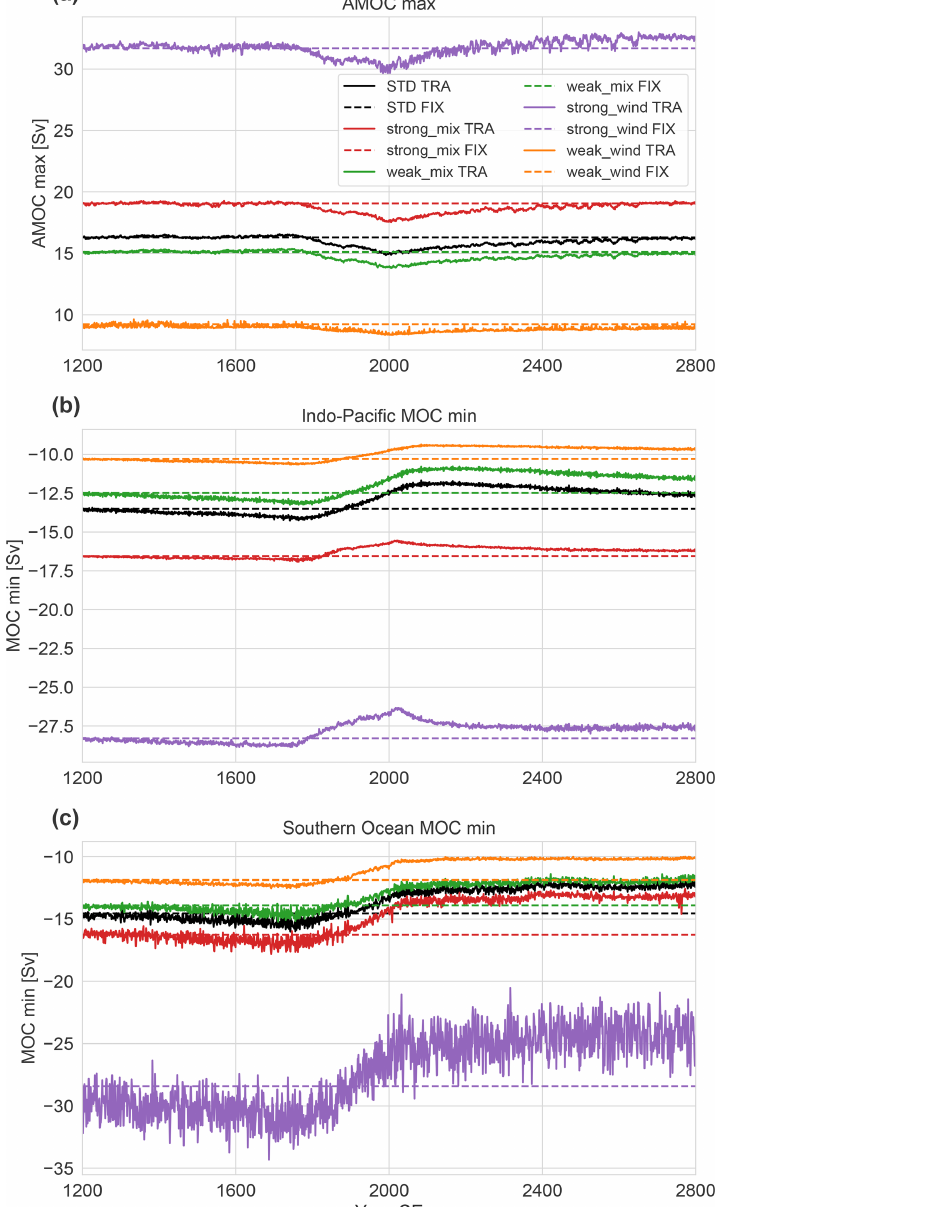
Figure A4. For simulations with varying parameters: (a) Atlantic Meridional Overturning Circulation (AMOC) maximum, (b) minimum of the MOC in the combined Pacific and Indian basin (IPMOC) and (c) in the Southern Ocean (SOMOC). Either the wind stress or mixing (i.e. diapycnal diffusivity parameter) is doubled or halved, respectively. TRA stands for transient simulations and FIX for fixed-circulation